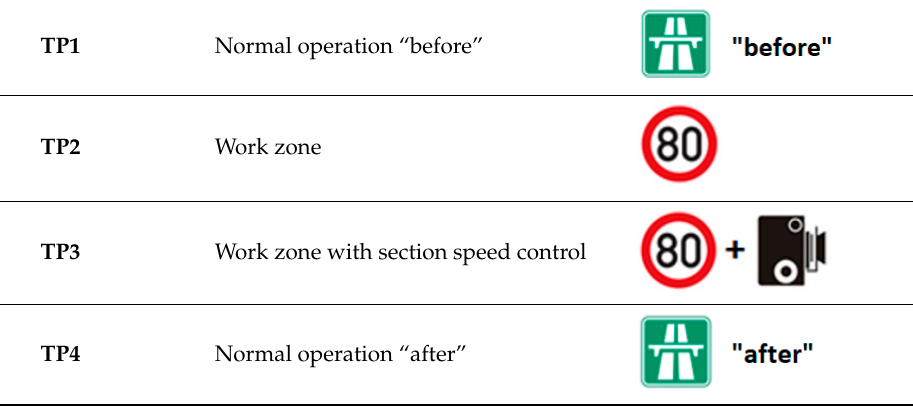
Table 1. Overview of analysed time periods and their graphical symbols. TP1